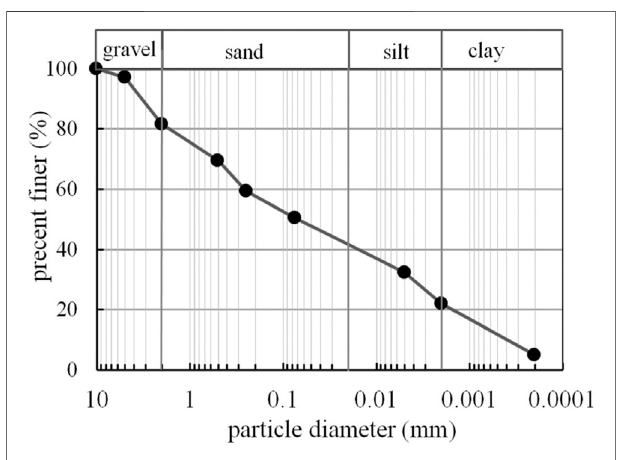
FIGURE 2 | The grain size distribution of